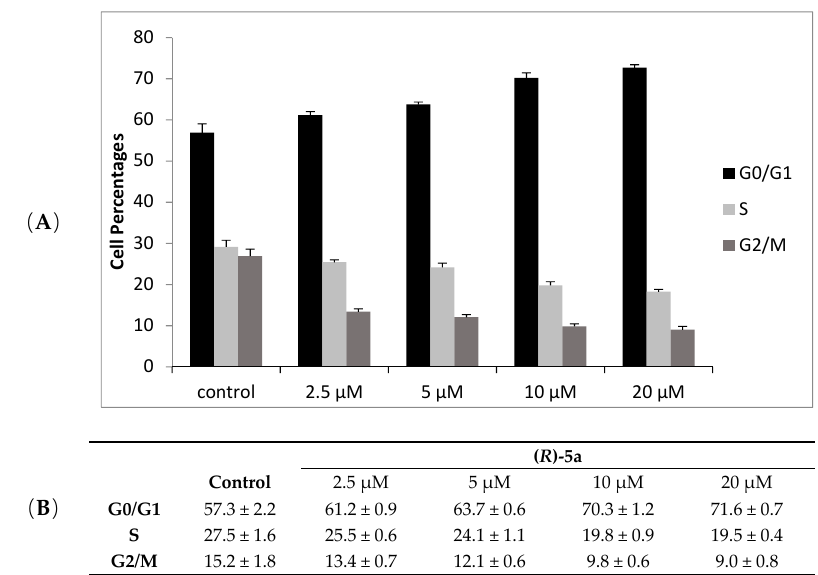
Figure 1. Cell cycle distribution of A2780 cells in the presence of different concentrations of ( R )-5a . Histograms ( A ) and cell percentage values ( B ). Mean values ± SD of four experiments are reported.